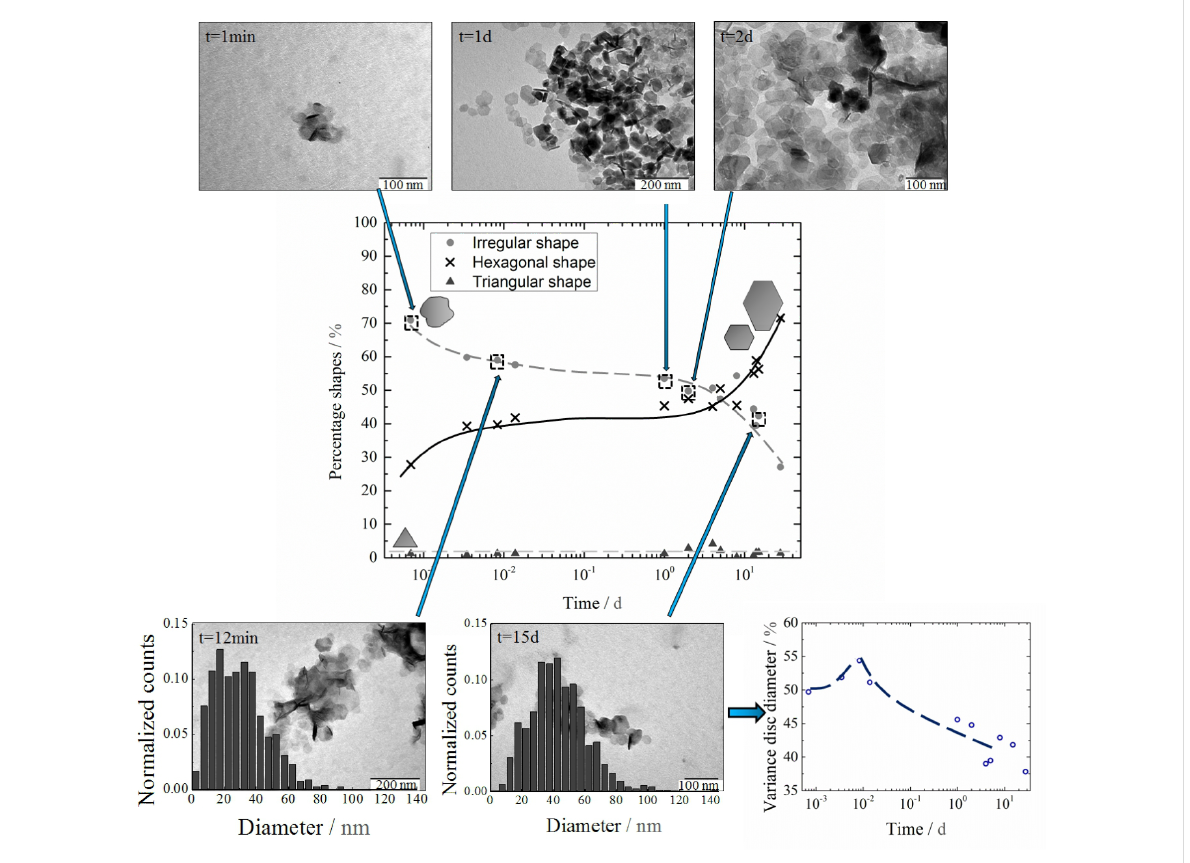
Figure 2: (a)–(c) Change in the electron diffraction pattern (shown with inverted intensity for better visibility) of diamond shaped particles with time. The dominating reflexes and rings are marked and indexed. (a) t = 5 min, (b) t = 1 d, (c) t = 2 d. (d) Bright field and dark field images of an incomplete diamond-shaped particle as well as the corresponding electron diffraction pattern of the disc. The highlighted areas in the dark field image corres- pond to the marked reflex of the electron diffraction pattern. (e) Image of an incomplete irregularly-shaped particle. The inset shows an enlarged area within the disc revealing that it is composed of smaller subunits. (f) HRTEM image of a final, stoichiometric monocrystalline disc, obtained after 28 days. The inset shows that the final nanoparticles are not